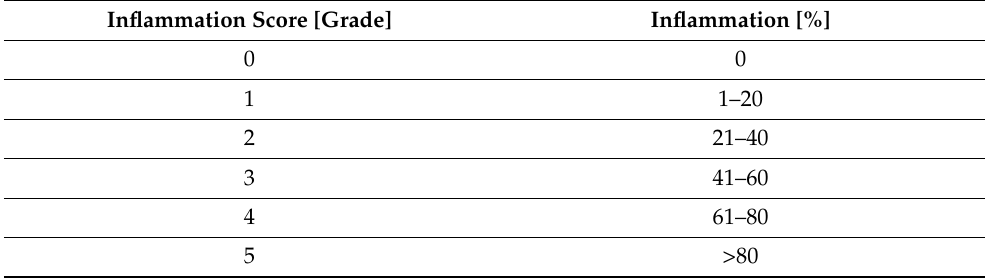
Table 1. Overview of the determined inflammation score in grades and